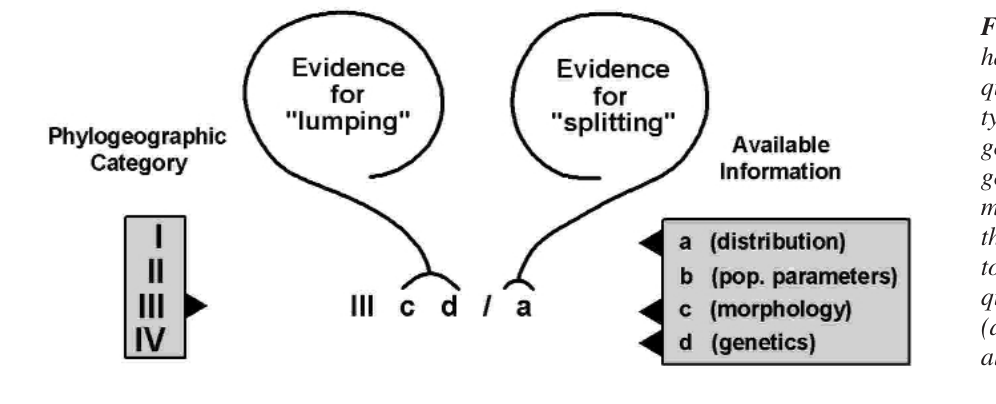
Fig. 3. A short- hand method for qualifying